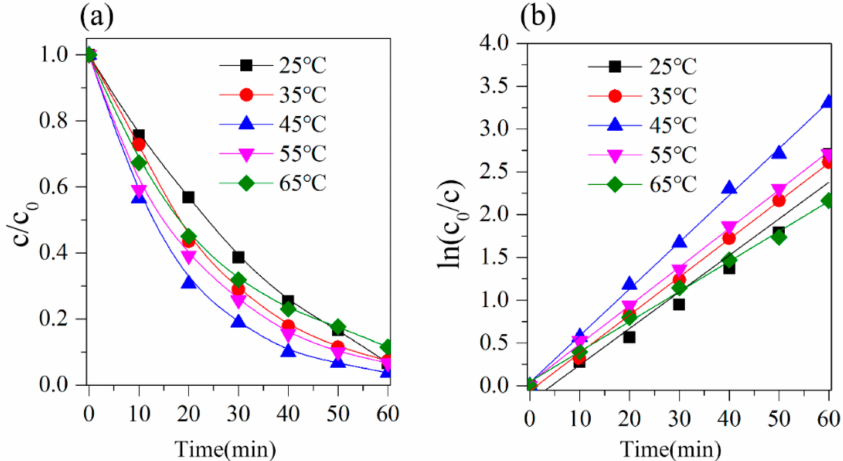
Figure 4. E ff ect of temperature on degradation ( a ); e ff ect of temperature ( b ) on kinetic constant; [C 4 BthPF 6 ] = 0.1 mM, pH = 5.06, [H 2 O 2 ] = 100